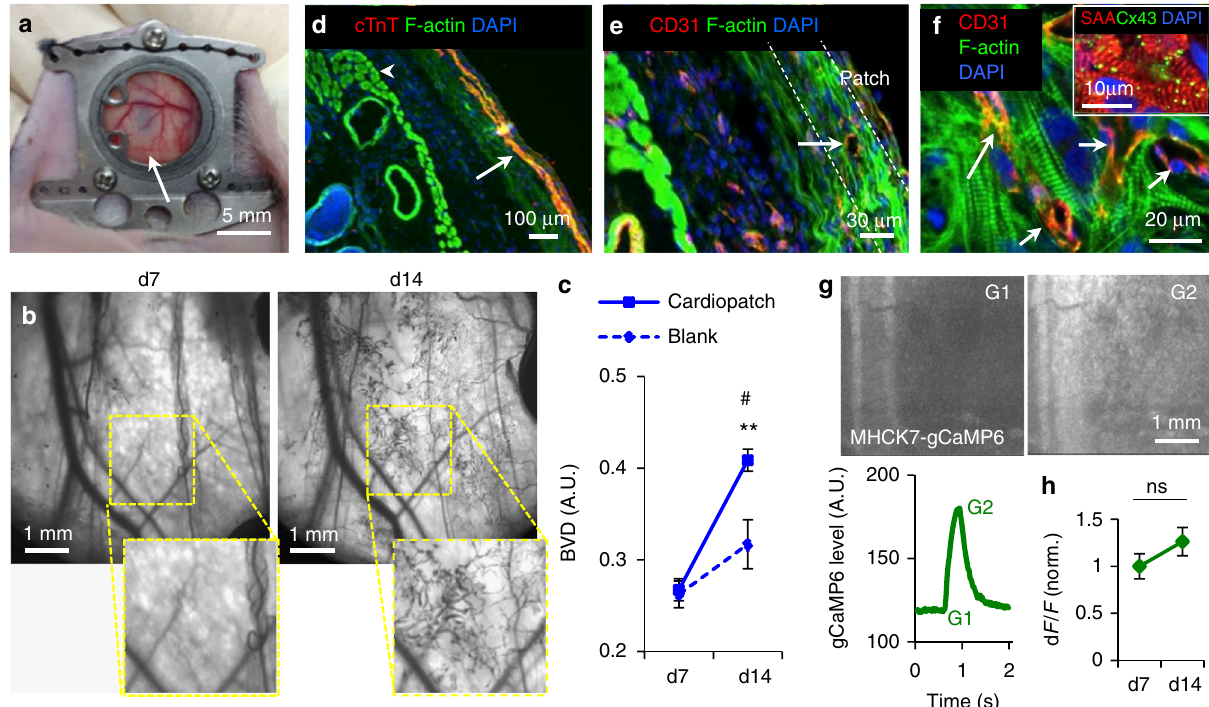
Fig. 6 In vivo vascularization of cardiopatches. a Representative photograph of an implanted 3-week-old cardiopatch (arrow) in a dorsal skinfold window chamber of a nude mouse. b , c Intravital raw vascularization images ( b ) and quanti fi cation of blood vessel density (BVD, c ) of cardiopatches on d7 and d14 post implantation relative to blank (Cerex® frame-only) controls; n = 18 mice (15 cardiopatches from 3 differentiations, 3 blank controls); repeated measures ANOVA: time F-ratio 34.8 ( p < 0.0001), patch×time interaction effect F -ratio 6.81 ( p < 0.02); for cardiopatch at d14: ** p < 0.0001 vs. cardiopatch at d7, # p < 0.027 vs. blank at d14, post hoc Tukey ’ s tests. d , e Representative cross-sections of explanted cardiopatches after 2 weeks in vivo stained for F-actin, cTnT ( d , arrow showing the cardiopatch) and CD31 ( e , arrow showing a capillary lumen). f Representative en face image of cardiopatch explanted 2 weeks post implantation stained for F-actin and CD31 (arrows pointing to vessel lumens), and SAA and Cx43 (inset). g Representative fl uorescence images and time trace of gCaMP6 signal during cardiopatch spontaneous activity 1 week after implantation; f , cardiopatch frame. h Ca 2+ transient amplitude assessed as relative gCaMP6 fl uorescence (d F / F ) in cardiopatches at d7 and d14 following implantation; n = 12 patches from two differentiations; p = 0.2, paired t -test. Data are presented as mean ± SEM. Scale bars a 5 mm; b 1 mm; d 100 µ m; e 30 µ m; f 20 µ m (inset 10 µ m); g 1